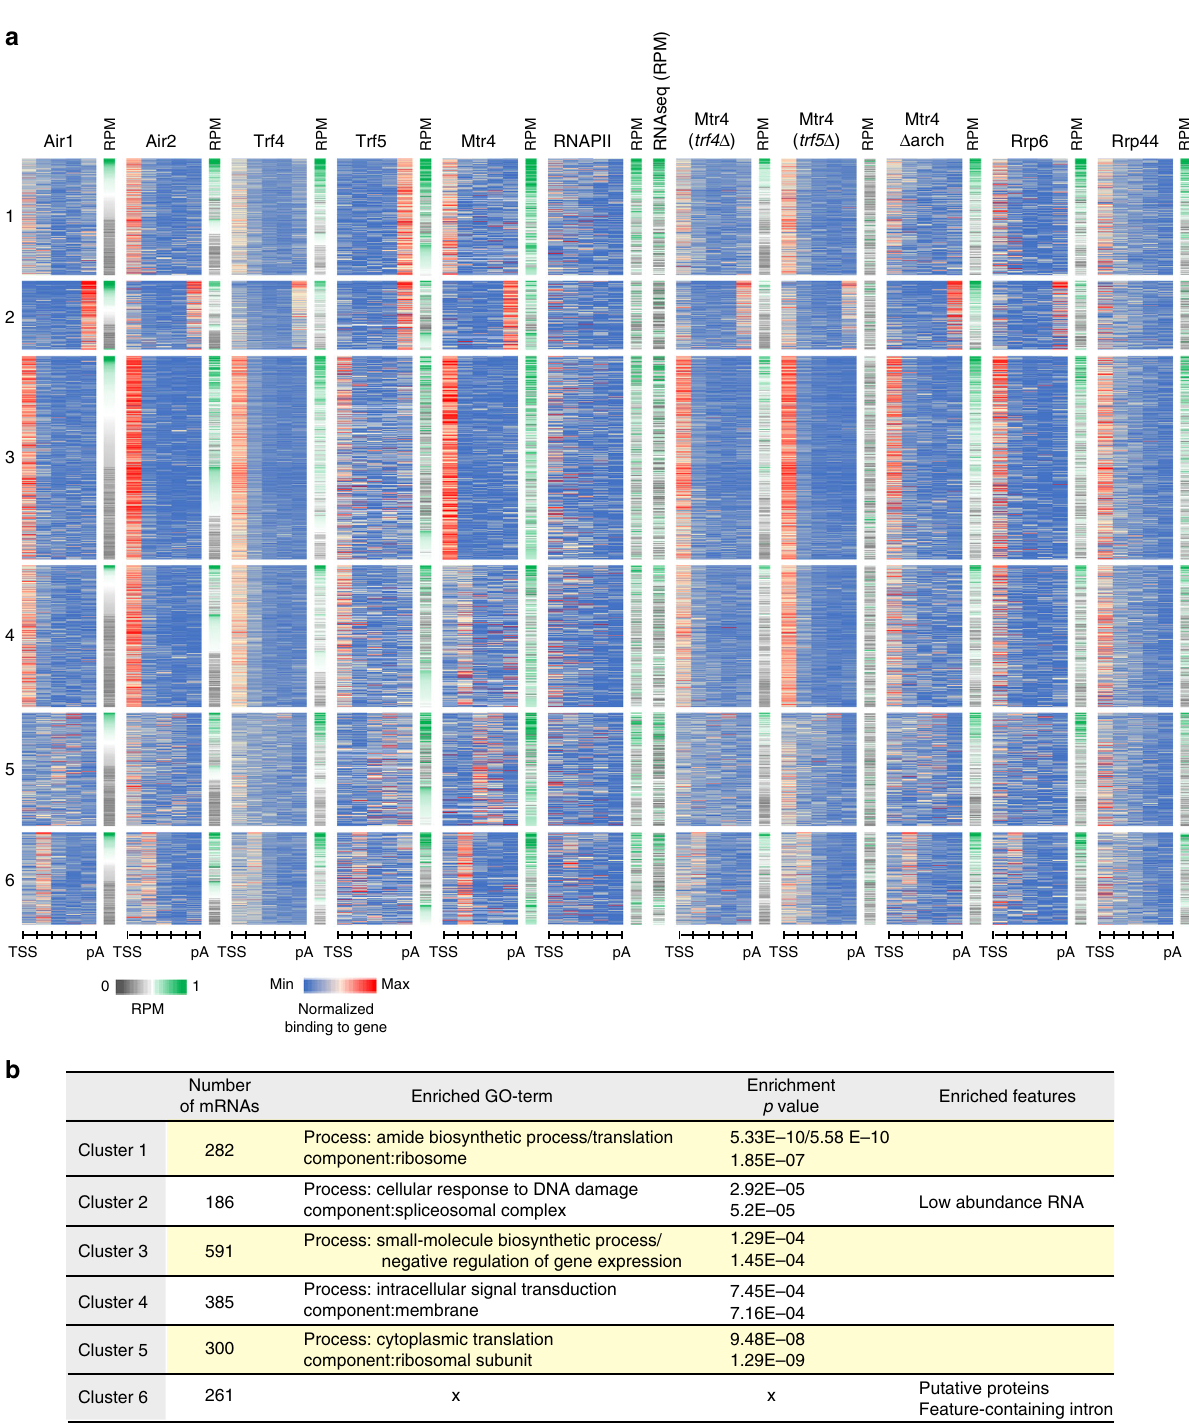
Fig. 5 Heat maps for distribution of TRAMP components on each mRNA. a Heat map showing binding across individual mRNAs of different factors. The top 1000 protein-coding genes recovered in CRAC with each TRAMP component were selected and combined (2005 mRNAs in total). Each transcript was divided into fi ve bins of equal length from TSS to pA site. Binding across each bin was calculated as a fraction of total binding across individual gene (set to 1). The number of reads was averaged between two biological replicates. Only the coverage of Air1, Air2, Trf4, Trf5, and Mtr4 along each transcript was used for Euclidean distance-based clustering. Other datasets shown were not included in the clustering analysis but are sorted according to the clustered list. The data are displayed as heat maps. The RPM for each transcript recovered by each protein was calculated and represented as independent heat maps. See Supplementary Data 5 for cluster composition. b Enriched GO terms 43 and features for clusters of mRNA de fi ned in a